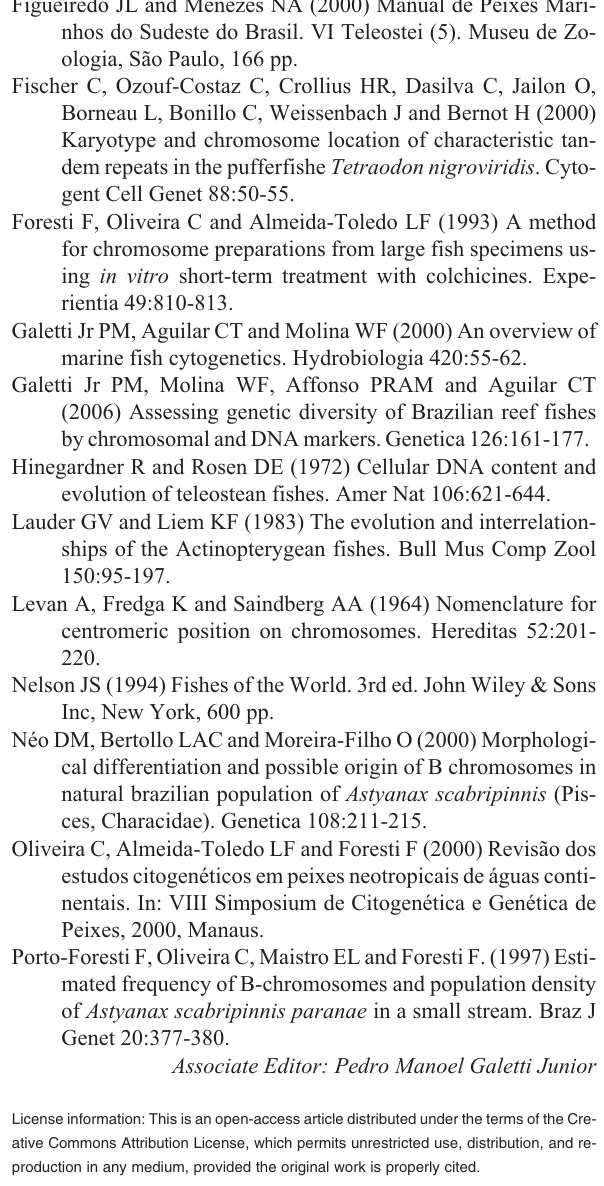
Figueiredo JL and Menezes NA (2000) Manual de Peixes Mari- nhos do Sudeste do Brasil. VI Teleostei (5). Museu de Zo- ologia, São Paulo, 166